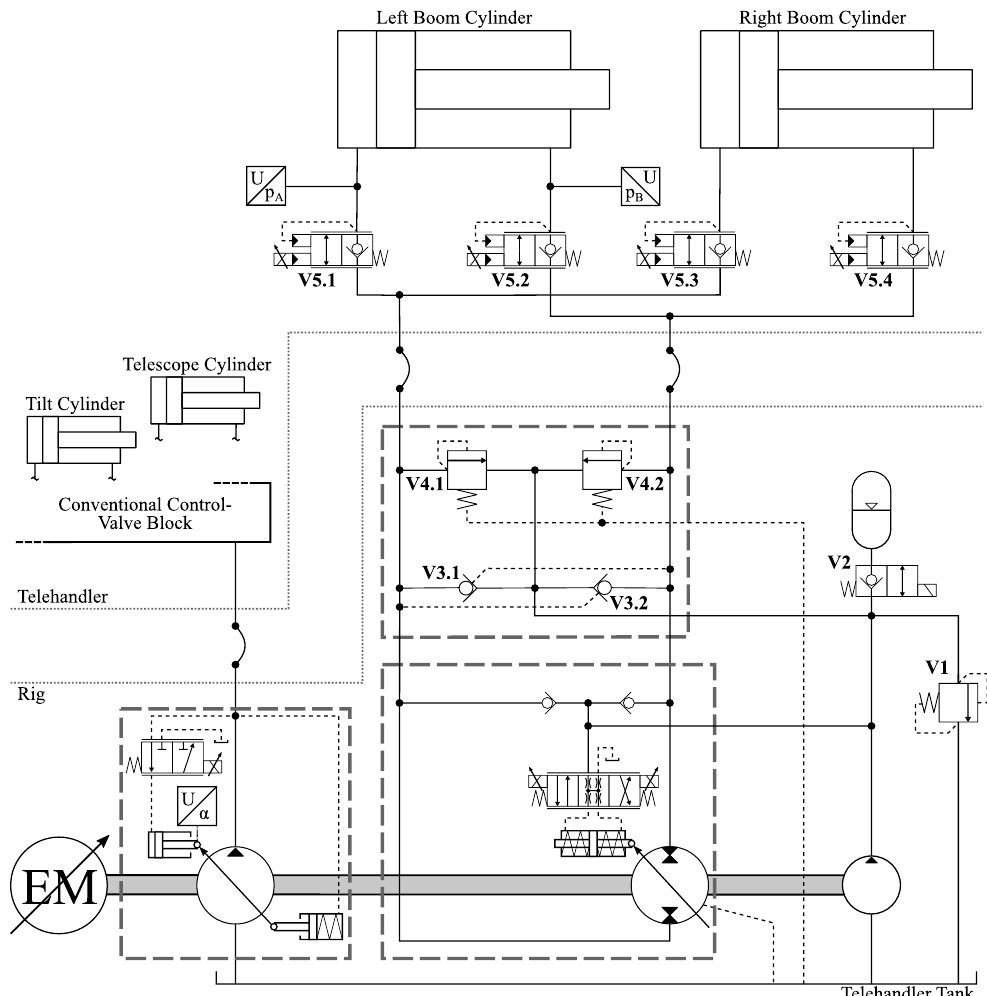
Figure 4. Hydraulic schematics of the improved system with displacement-controlled boom and valve-controlled tilt, as well as telescope function; broken lines mark the two pump housings and the valve